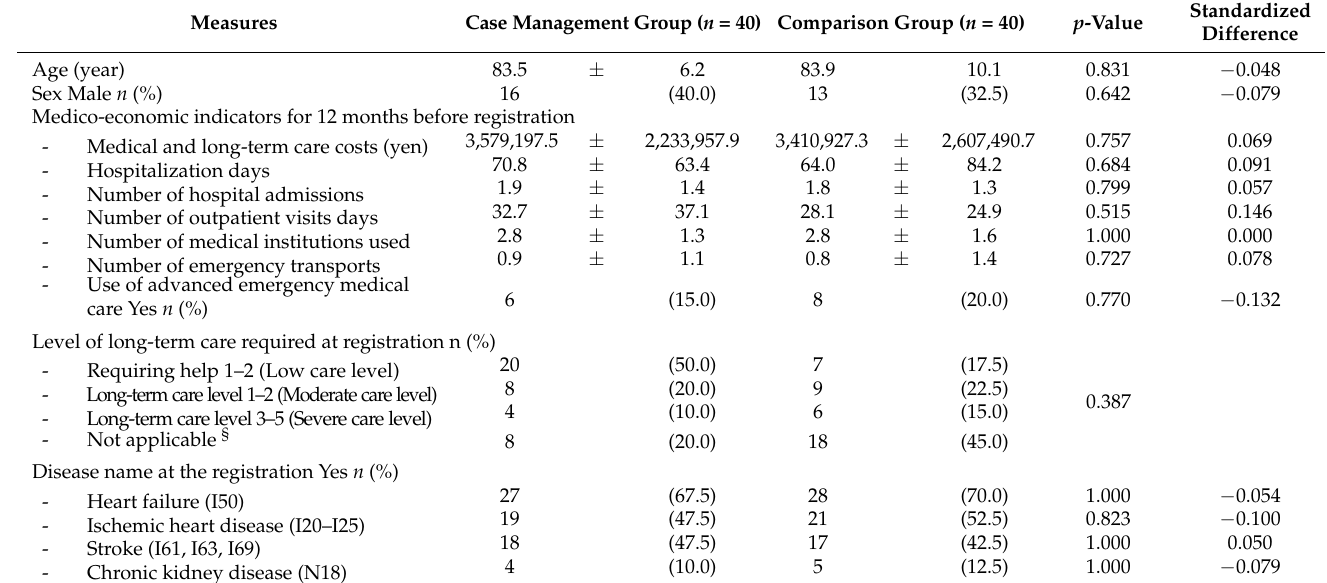
Table 2. Baseline comparison of the two groups after propensity score matching. Mean ± Standard